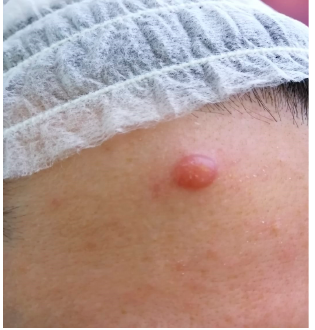
Figure 1. Primary lesion before surgical treatment.